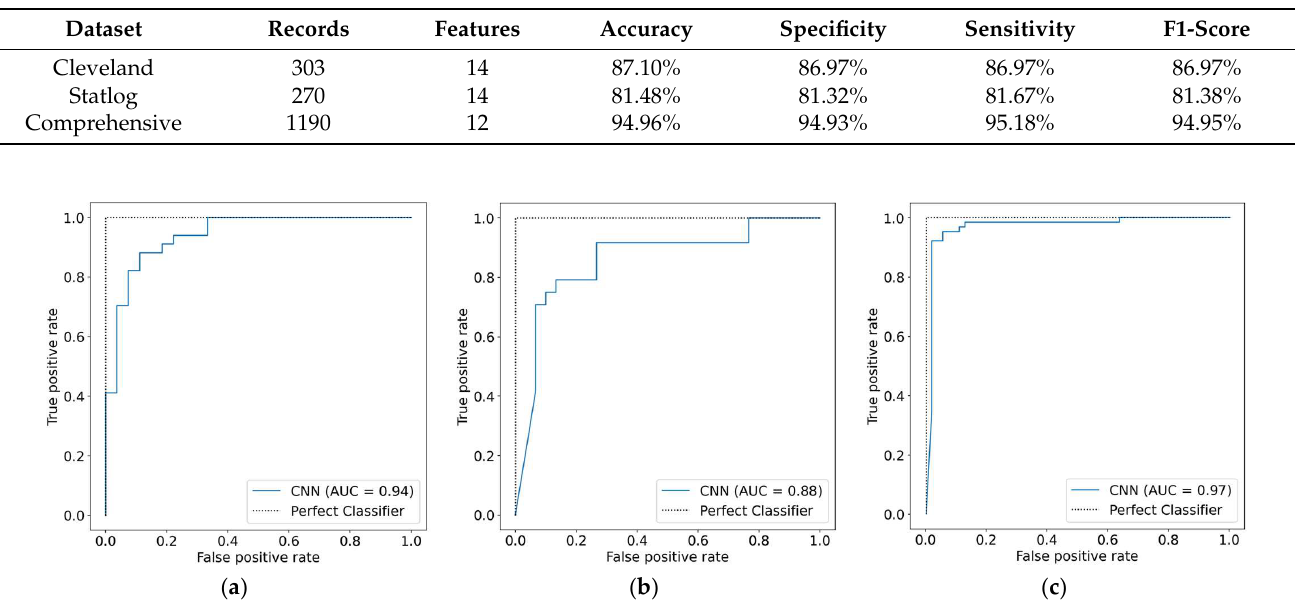
Figure 9. AUC measures of the 1D-CNN model. ( a ) Cleveland dataset; ( b ) Statlog dataset; ( c ) Comprehensive dataset.